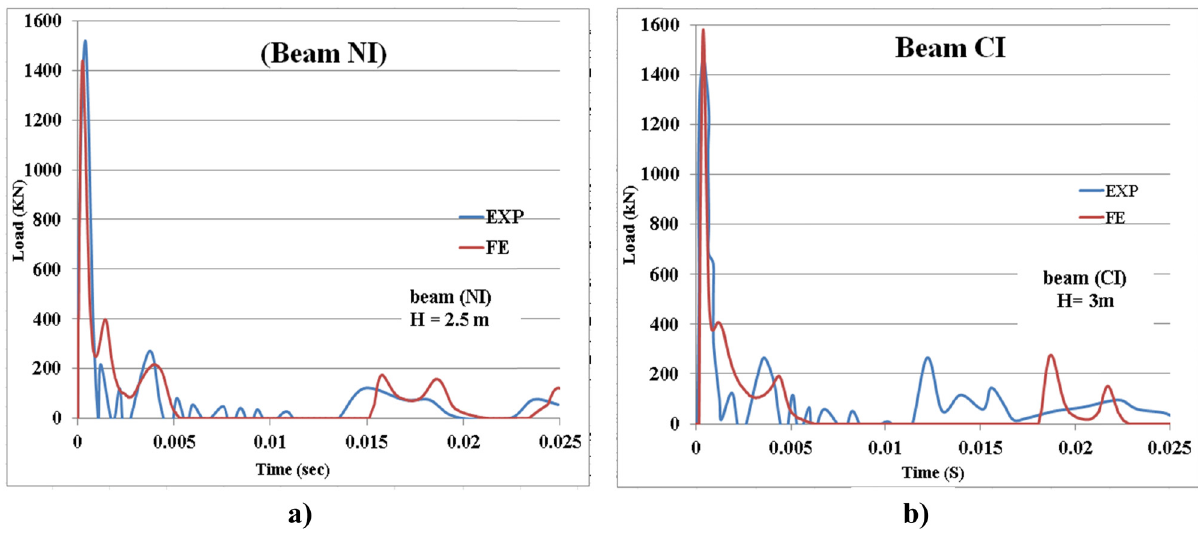
Figure 3: Comparison between the experimental data and numerical result: ( a ) impact force – time history of the beam ( NI ) and ( b ) impact force – time history of the beam ( CI ) .